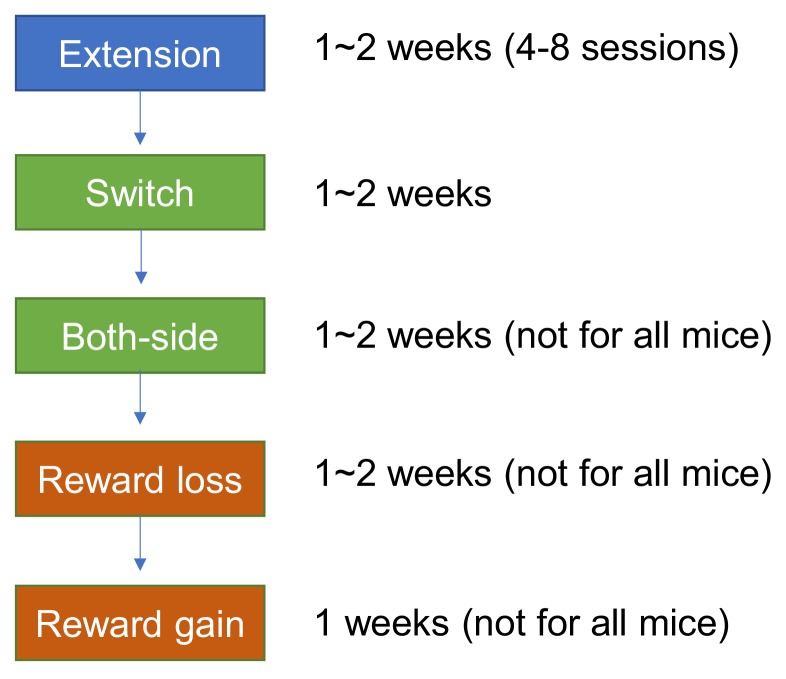
Schedule of running experimental conditions.All the experimental conditions were performed in different weekly sessions.